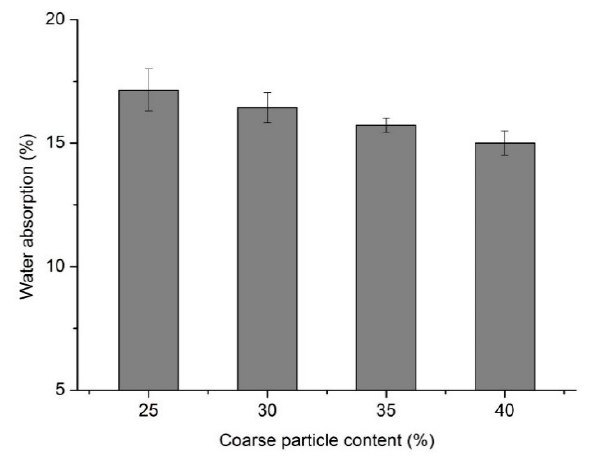
Figure 11. Water absorption of series III mixtures.